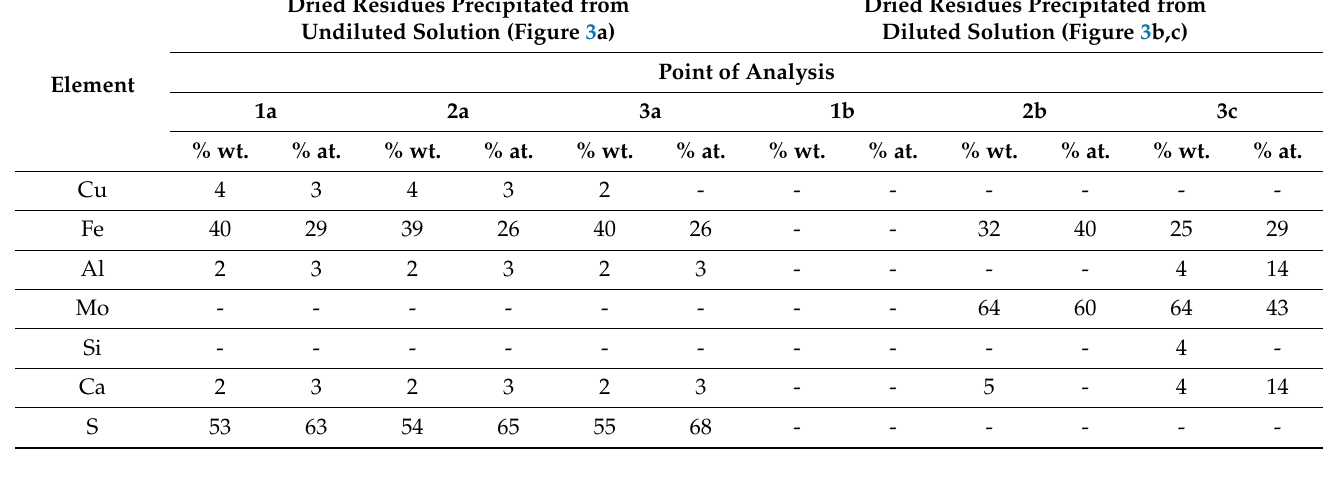
Figure 3. SEM images of the dried residues precipitated from leachate with marked chemical composition analysis points (results are presented in Table 1); ( a ) undiluted, ( b , c ) diluted. Table 1. Results of chemical composition analysis of the dried residues precipitated from leachate (EDS, SEM) at points shown in Figure 3; specimen from undiluted solution (Figure 3a); specimen from diluted solution (Figure 3b,c).